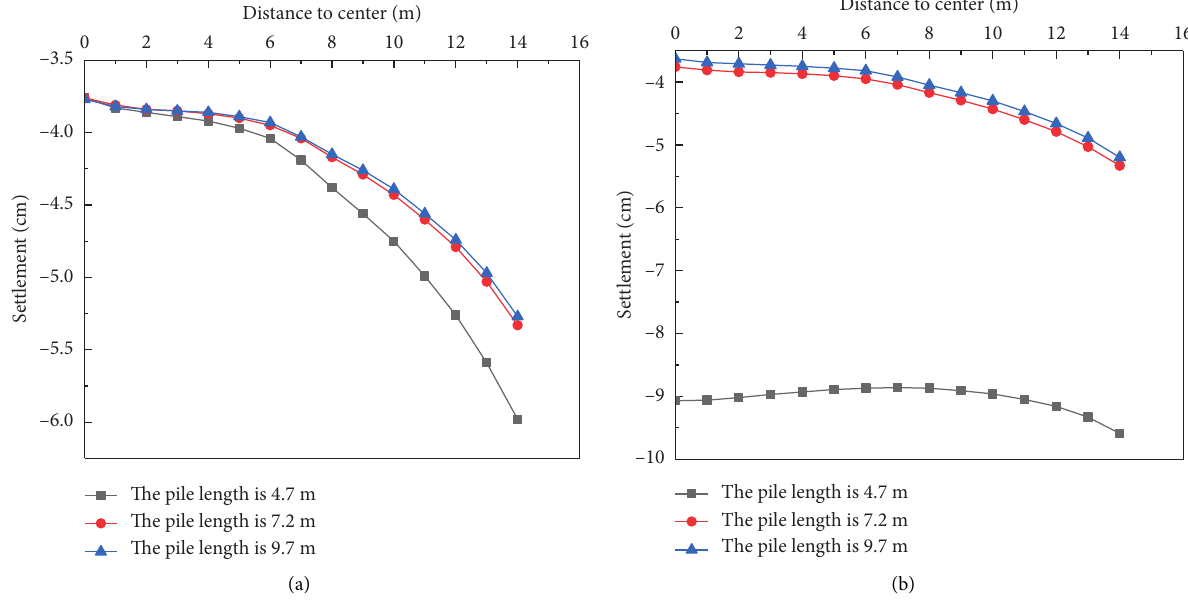
Figure 14: Postconstruction settlement diagram of the old subgrade surface under different piles lengths. (a) Variations in the pile length under the existing road slope. (b) Variations in the pile length under the existing subgrade and new embankment.